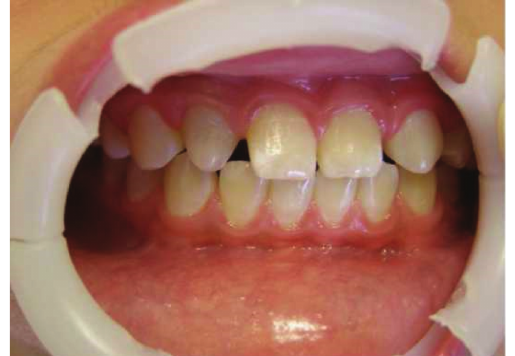
Figure 4: Clinical photography of maxillary right lateral incisor at the twenty-month follow-up